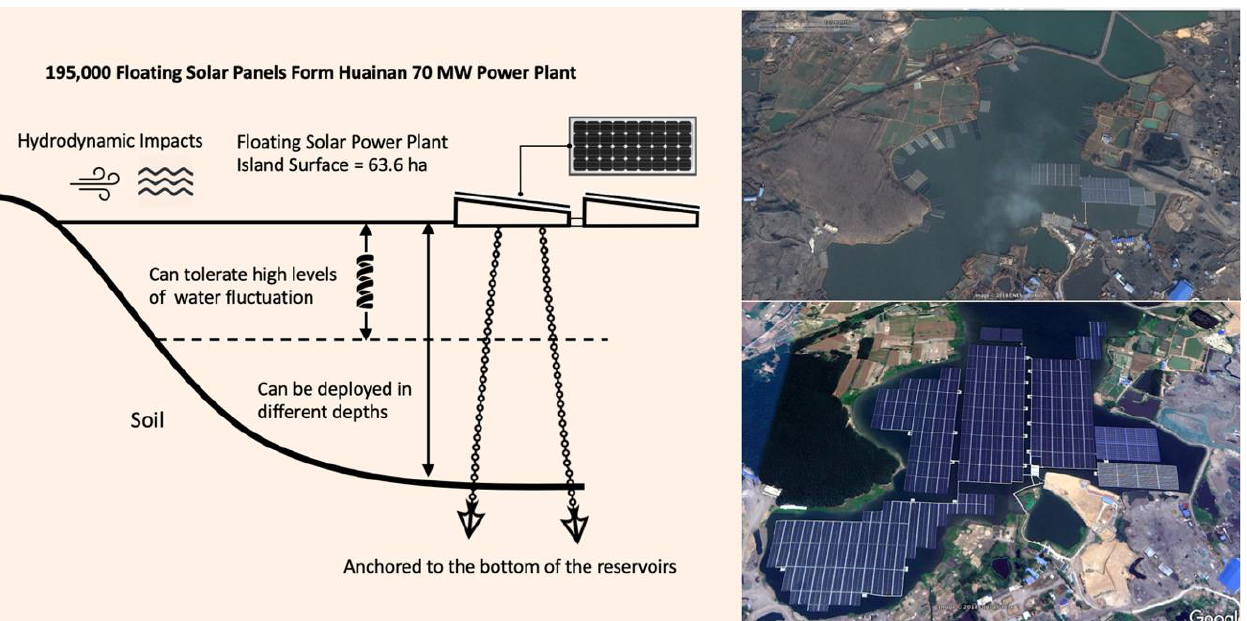
Figure 4. Schematic representation of the installed FPV plant ( left ) and satellite images of the FPV on the flooded coal mine in Anhui Province that show the beginning and the current state of the project, taken from Google Earth Pro ( right ).